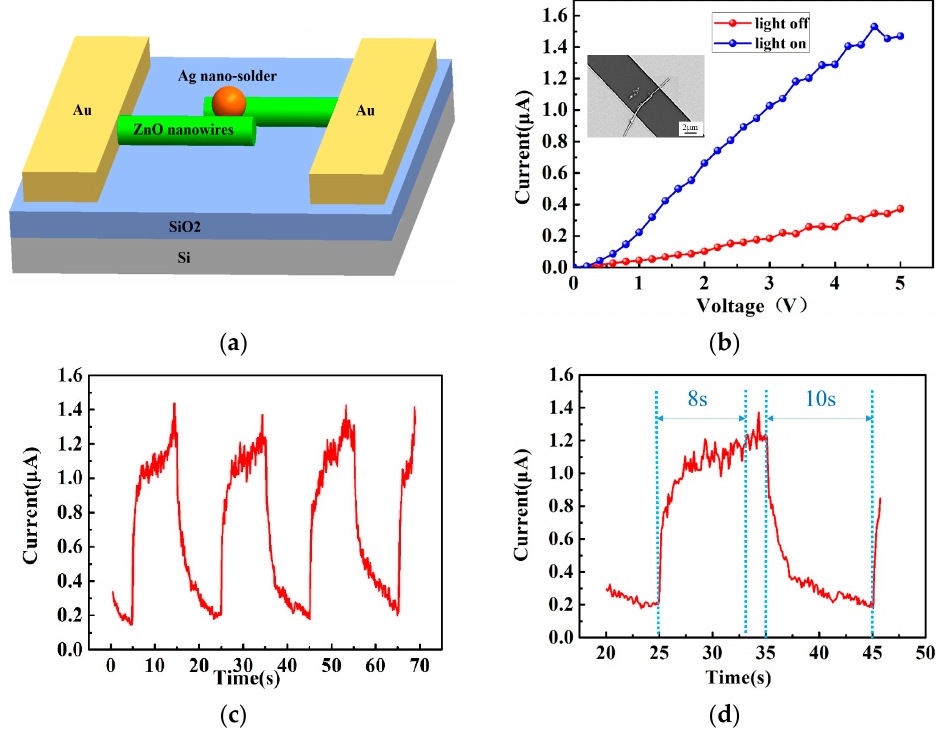
Figure 6. The photoelectric properties test of the ZnO-Ag-ZnO interconnection structure. ( a ) Schematic of the device based on the ZnO-Ag-ZnO interconnect structure; ( b ) I-V curve of photocurrent and dark current of the device; ( c ) photoresponse curve of the interconnection device; ( d ) the response and recovery time of a single response curve.